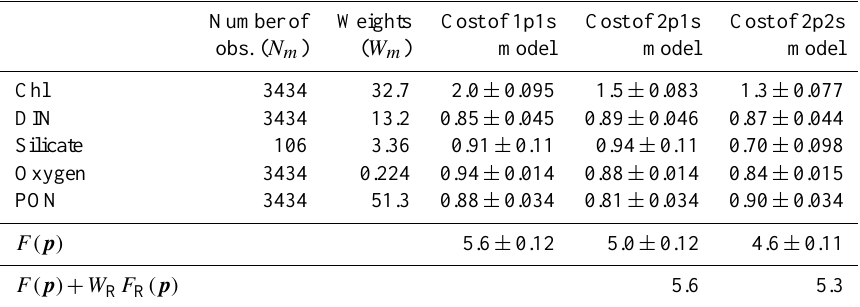
Table 4. Number of assimilated observations per data type ( N m ), cost function weights ( W m ), optimal cost function values (totals and individual contributions from the different variable types) and associated standard errors resulting from uncertainties in the observations. The standard errors were calculated by Monte Carlo analysis as described in the